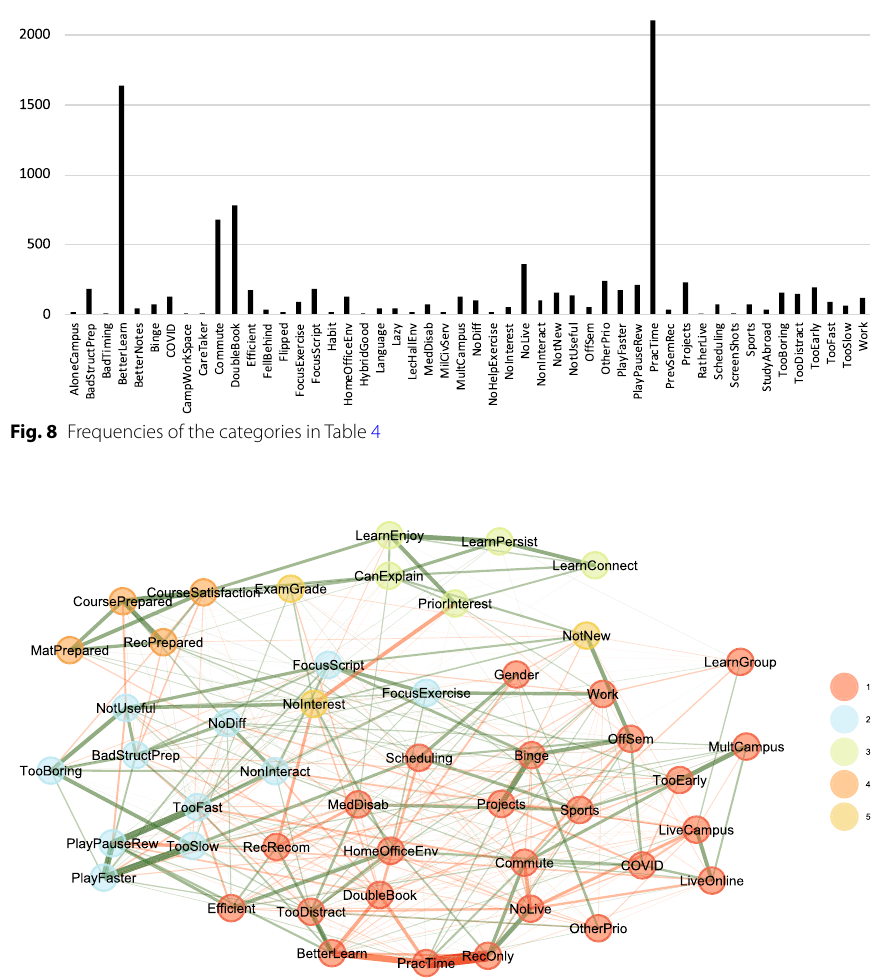
Fig. 9 Exploratory cluster analysis for the categories in Table 4 that were mentioned more than 50 times, as well as course‑relevant attributes (see Table 1), only considering RecOnly Table 2 and Fig.